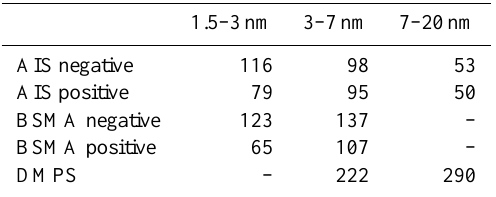
Table 2. Number of new particle formation events for which growth rate was calculated separated according to the particle size, the in- strument used for size distribution measurement and the electric charge polarity of the particles. The size range 7–20nm is out of the detection range of BSMA and the size range 1.5–3nm is out of the detection range of